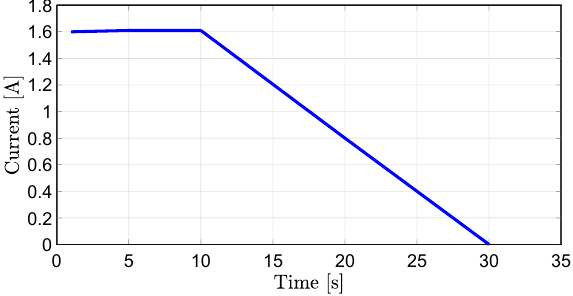
Figure 12. Current limiting performance PTC.